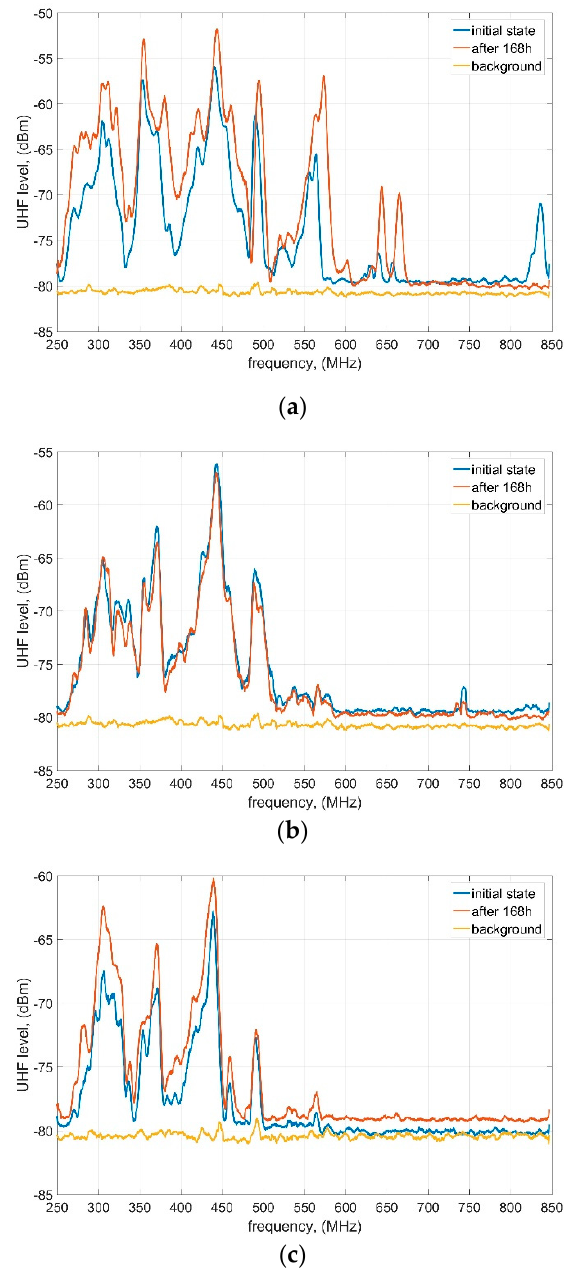
Figure 2. UHF spectrum of the signals emitted by SD at the initial state and after 168 h of continuous PD generation: ( a ) PBP; ( b ) PTFE; ( c ) GLS.